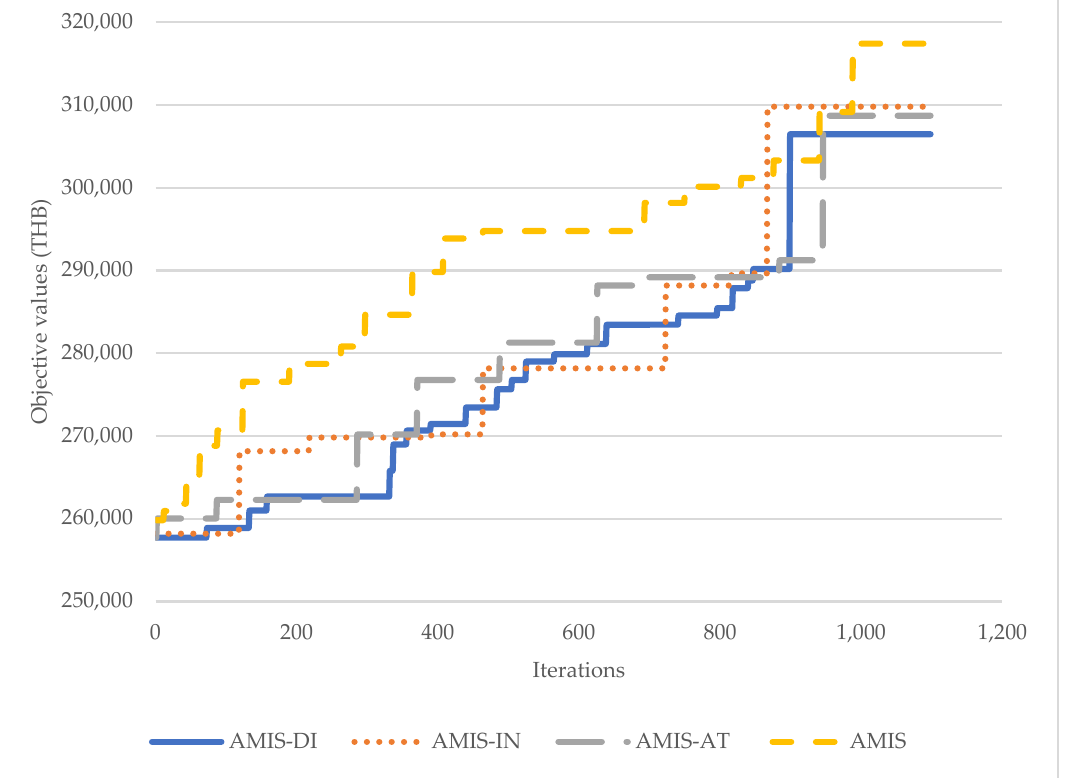
Figure 5. Behavior of AMIS subalgorithms.